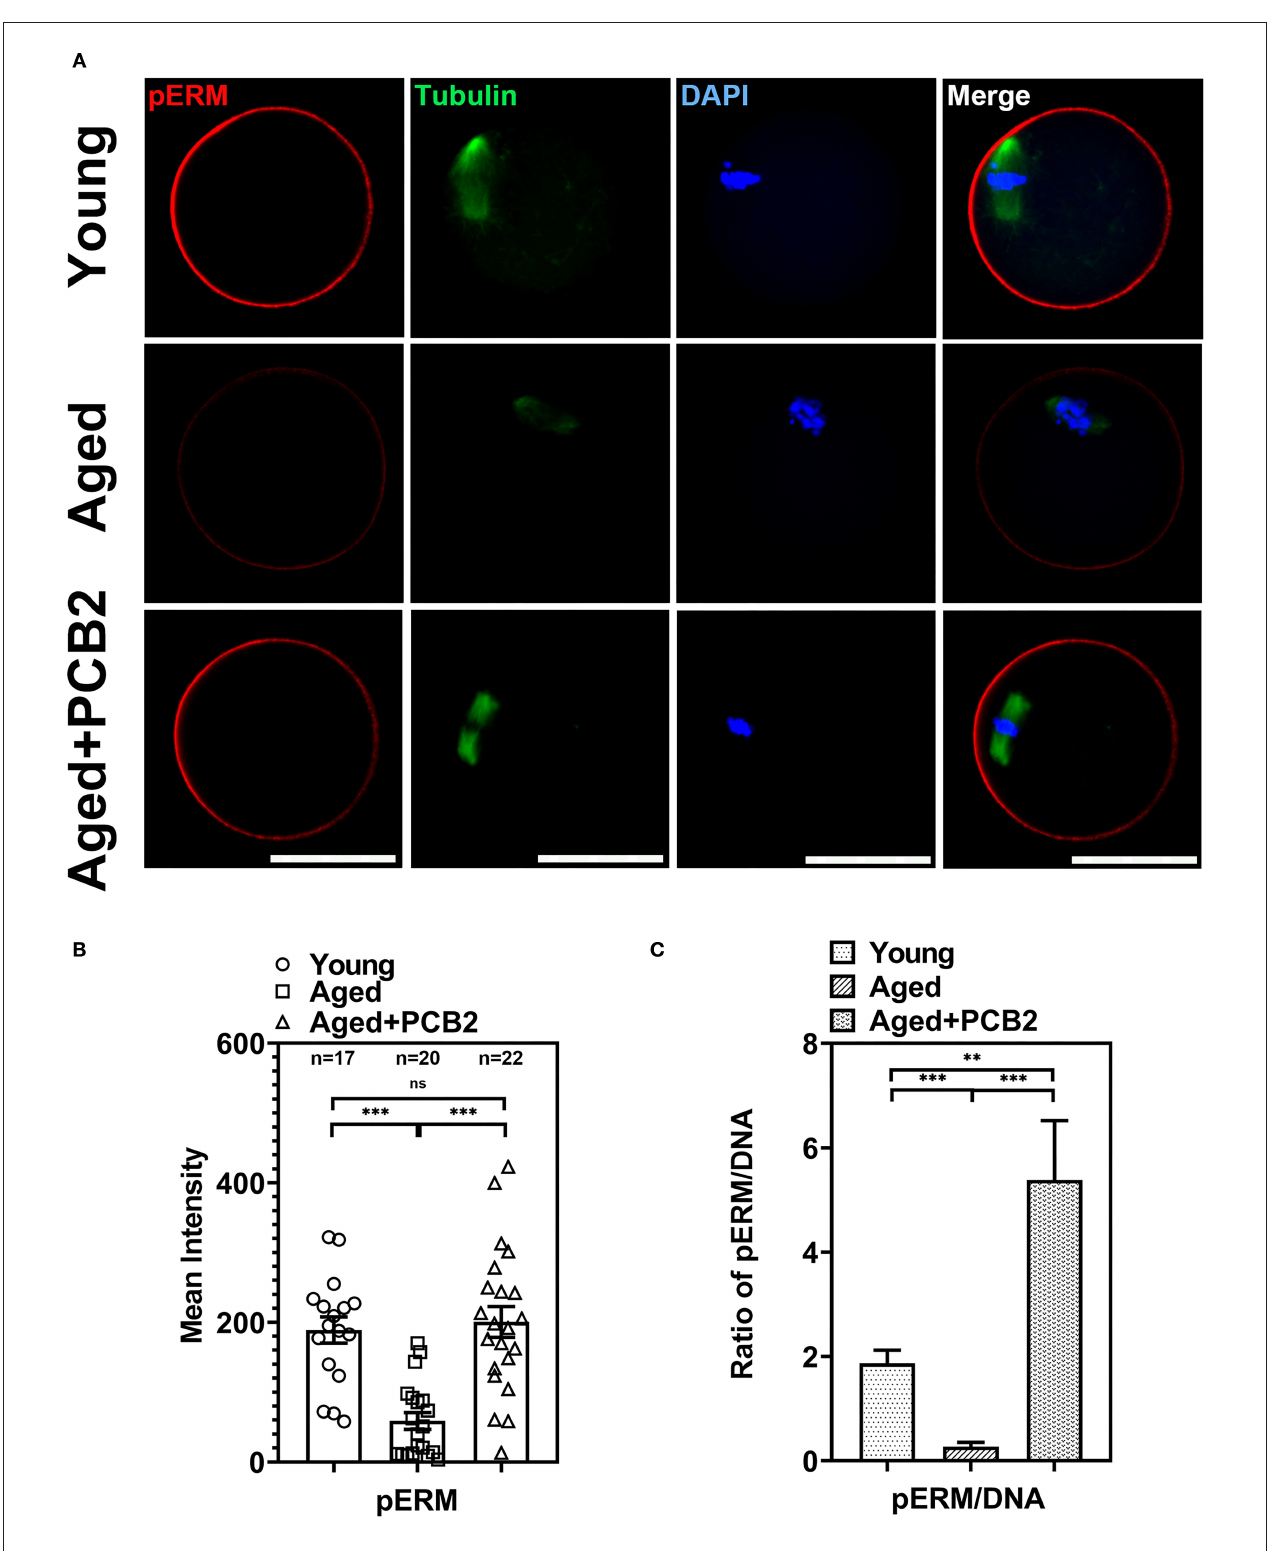
FIGURE 2 | Effects of PCB2 on pERM expression and spindle formation during in vitro culture of aged oocytes. (A) IF staining of in vitro matured oocytes for pERM and tubulin. DNA was counterstained with DAPI (blue). Scale bar, 50 µ m. (B) Fluorescence intensity of pERM signals was recorded in different groups. (C) The ratio of pERM to DNA fluorescence. Data are presented as mean percentage (mean ± SEM) of at least three independent experiments. ** P < 0.01, *** P < 0.001. ns, non-significant difference, P > 0.05.